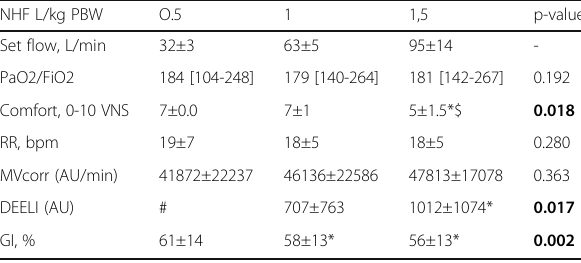
Table 1 (abstract 0001026). Physiological effects of